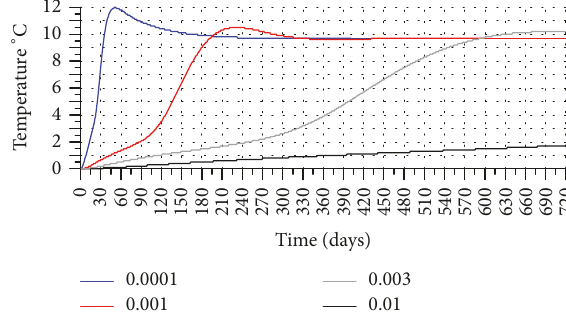
Figure 17: Thermal response (temperature rise, ∘ C) in a model element corresponding to Isotovsky hot spring after additional heat sources (4 × 8 MW) were assigned in the model 2km apart. Note: active circulation volume (volume fraction) used as a model sensitivity parameter here. (TOUGH2-EOS1) (6A +